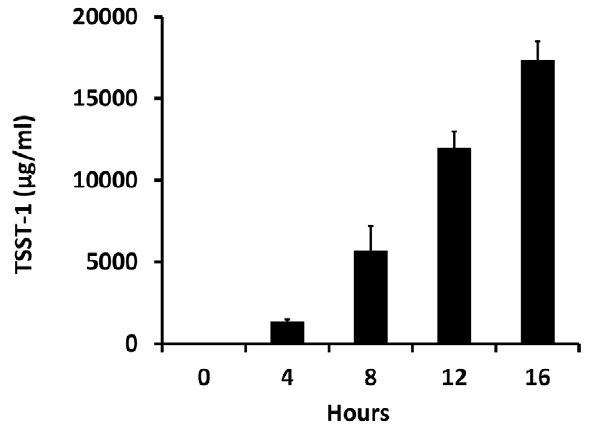
Figure 6. TSST-1 production in biofilms in tampon sacs. Staphylococcus aureus MN8 (10 7 /0.1 ml) were placed inside dialysis tubes that had been tied off on one end, and then tampons were inserted. The tampon sacs were immersed beneath Todd Hewitt 0.8% agar such that the open end of the dialysis tubing remained above the surface. The agar was allowed to solidify, and the tampons sacs were incubated for indicated times. TSST-1 was measured within the dialysis tube by knowing the pre- and post-weight of the tampons, eluting TSST-1 with distilled water, and quantifying TSST-1 by Western immunoblot